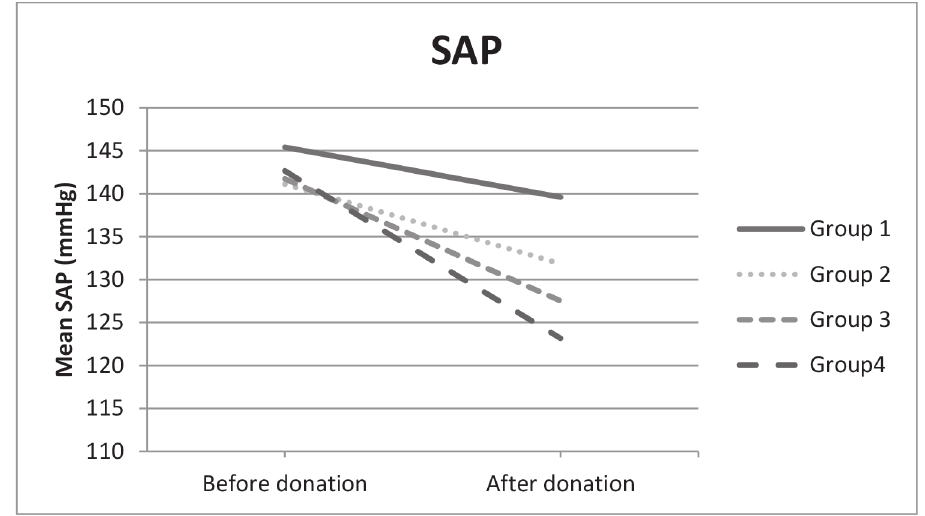
Figure 2 - Mean SAP values evidenced before and after the blood collection in each group.